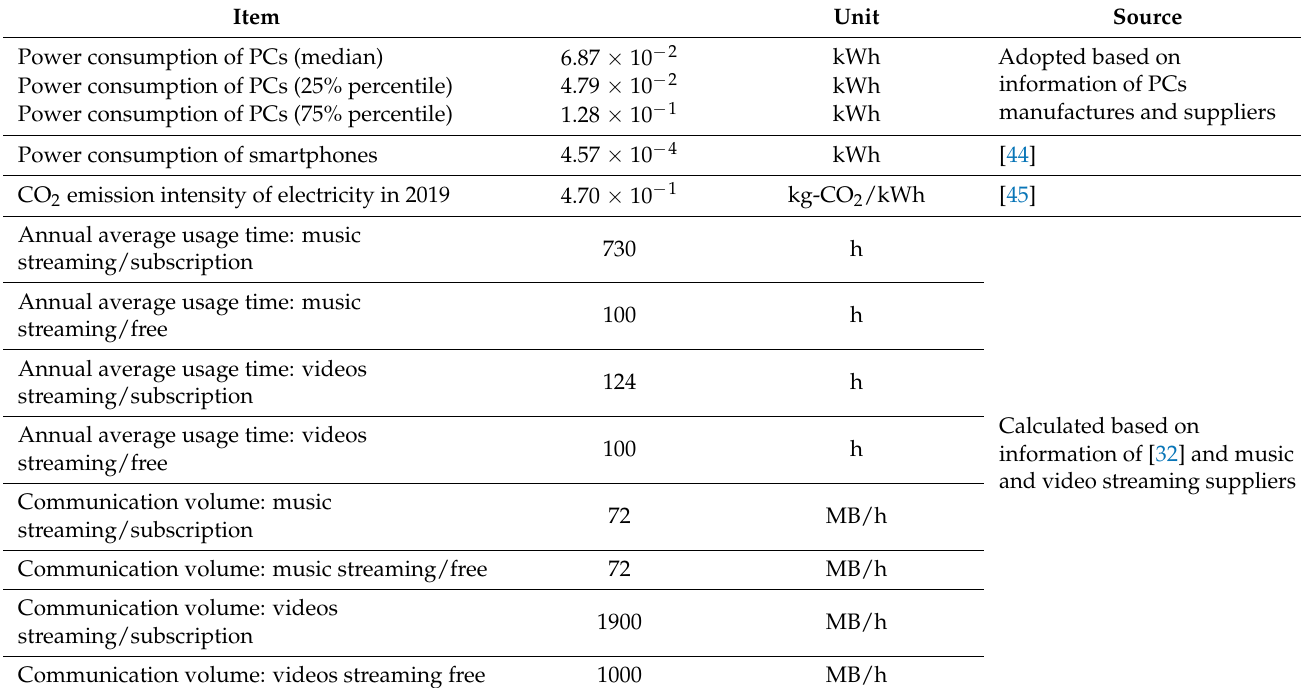
Table 3. Utilized data for usage process: listening and/or watching streaming by